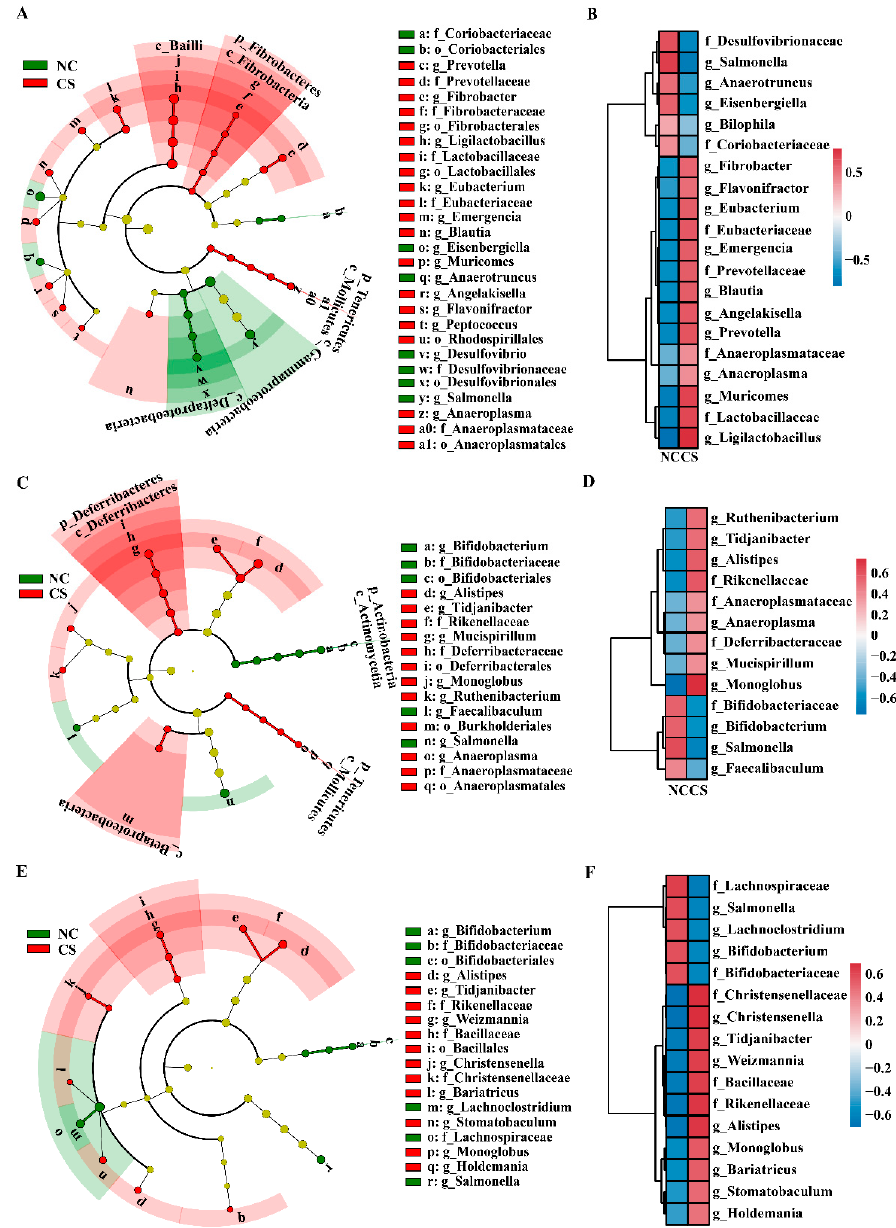
Figure 5. Taxonomic variation in the gut microbiota induced by cigarette smoke exposure. ( A , B ) Cladogram of LEfSe analysis (LDA > 3) of microbiota from feces ( A ) and heatmap showing relative abundances of differentially abundant genera and families identified through LEfSe analysis of feces ( B ). ( C , D ) Cladogram of LEfSe analysis (LDA > 3) of microbiota from colon ( C ) and heatmap showing relative abundances of differentially abundant genera and families identified through LEfSe analysis of colon ( D ). ( E , F ) Cladogram of LEfSe analysis (LDA > 3) of microbiota from cecal contents ( E ) and heatmap showing relative abundances of differentially abundant genera and families identified through LEfSe analysis of cecal contents ( F ). Different color nodes indicate microbial communities that are significantly enriched in corresponding groups and significantly different between groups. The graph of evolutionary branches in the cladogram plots from the center outward represents domain, kingdom, phylum, class, order, family, and genus at the taxonomic level. The size of each node that represents a species at each classification level is positively correlated with the abundance of the species. The yellow nodes represent species without significant